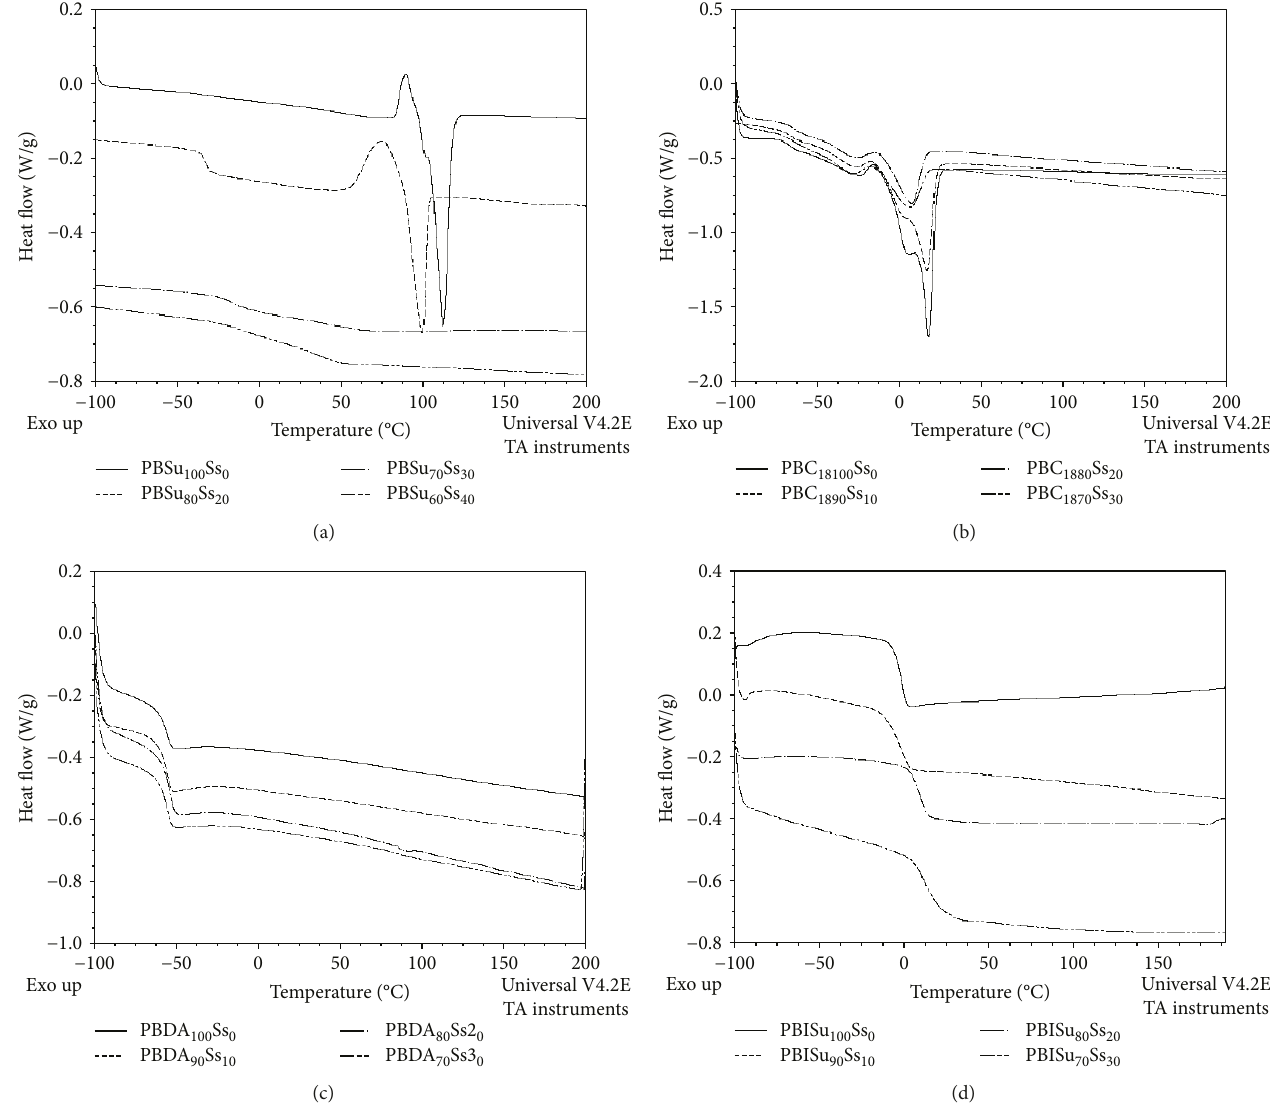
Figure 15: DSC curves of biobased oligoesters: (a) DSC curves of PBSu (d) DSC curves of PBISu